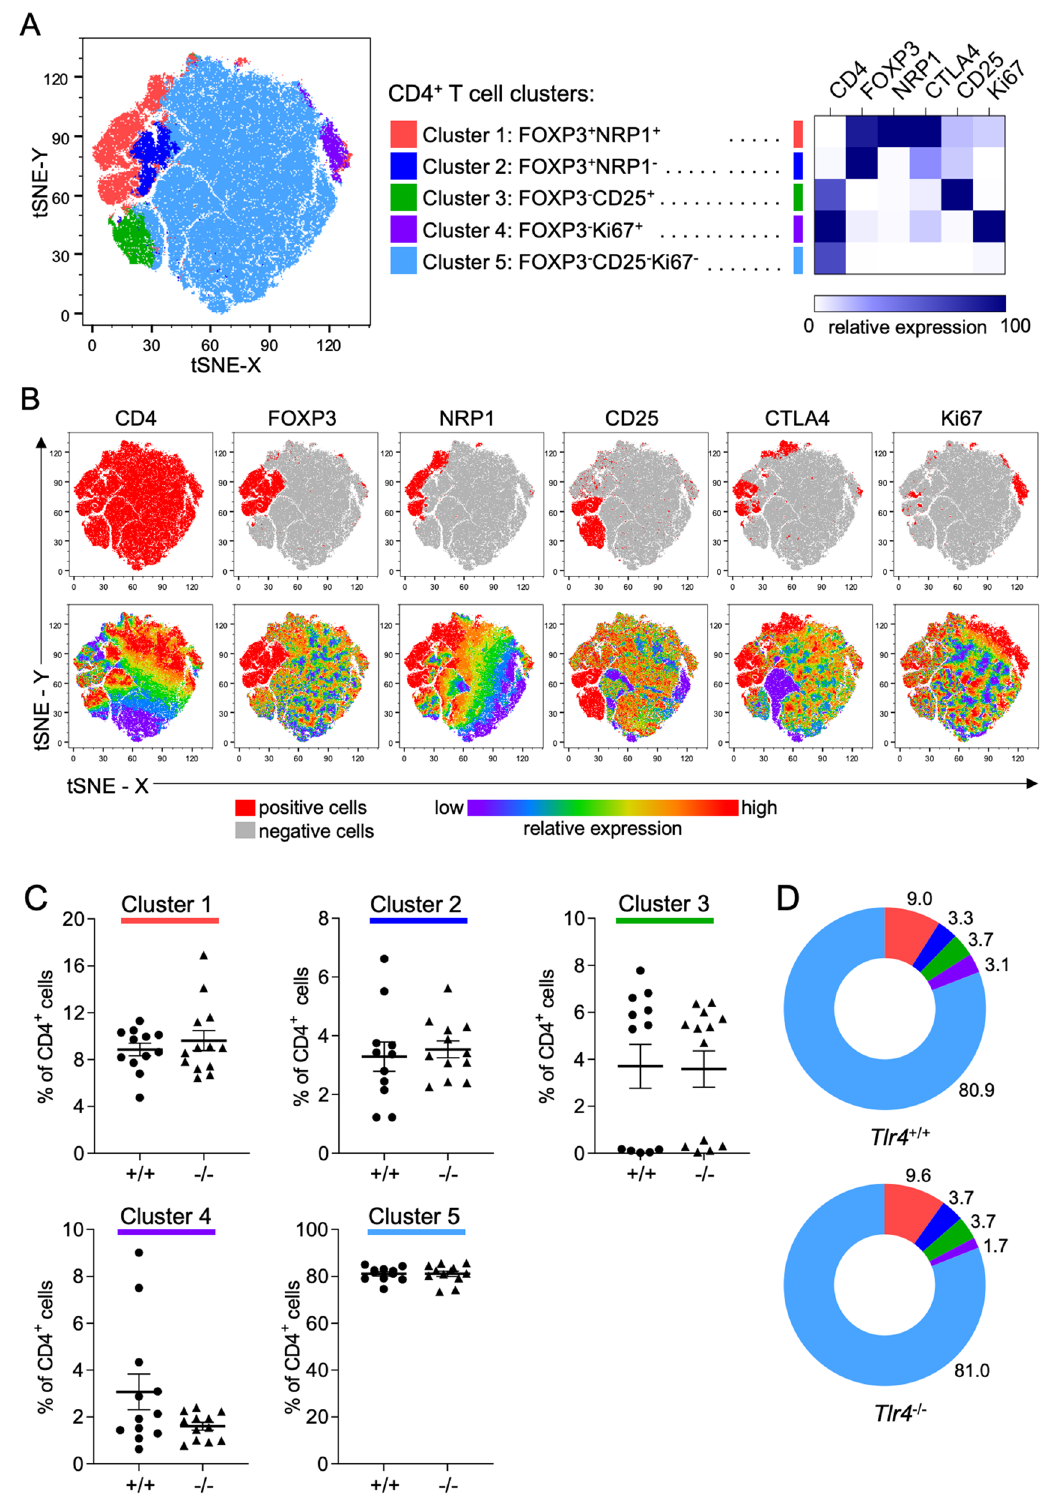
Figure 6. Assessment of the CD4 + T cell population by dimensionality-reducing tSNE algorithm. CD4 + T cells from the uterine dLN of Tlr4 +/+ (+/+) or Tlr4 − / − (−/−) mice on d 3.5 pc after mating with B6 males were analyzed by flow cytometry. The viable CD4 + T cells from all samples were concatenated into a single file and transformed by the tSNE algorithm. X-shift identified 5 unique cell clusters ( A ), and the relative expression intensity of each of CD4, FOXP3, NRP1, CD25, CTLA4, and Ki67 within each cluster was calculated and shown by a heat map ( A ). Cells positive for each marker are shown in red on the tSNE ( B —top row), and the relative expression of each marker is also shown ( B —bottom row). The percentage of cells comprised by each of the 6 clusters for the d 3.5 pc groups in Tlr4 +/+ and Tlr4 − / − mice was calculated. Symbols depict individual mice (n = 8–13/group) and data are also shown as mean ± SEM ( C ). Effects of genotype were assessed by unpaired Sidak t test. No effects of genotype were found. The contribution of each cluster to the tSNE in Tlr4 +/+ and Tlr4 − / − mice is shown as pie charts ( D